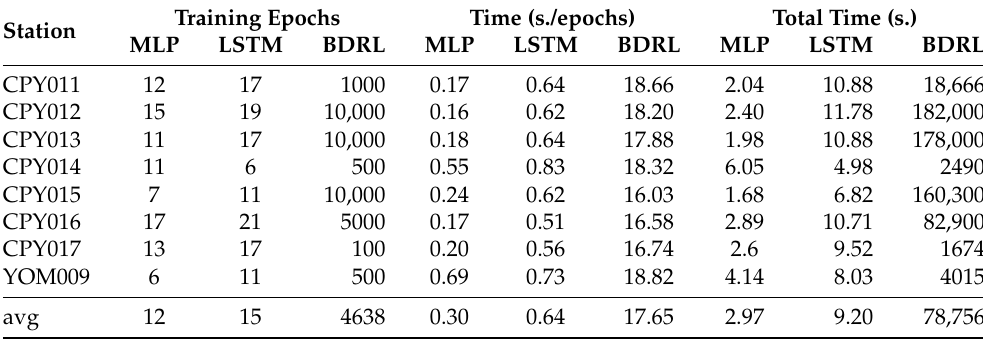
Table 5. The number of training epochs and the time spent on each epoch for each model.